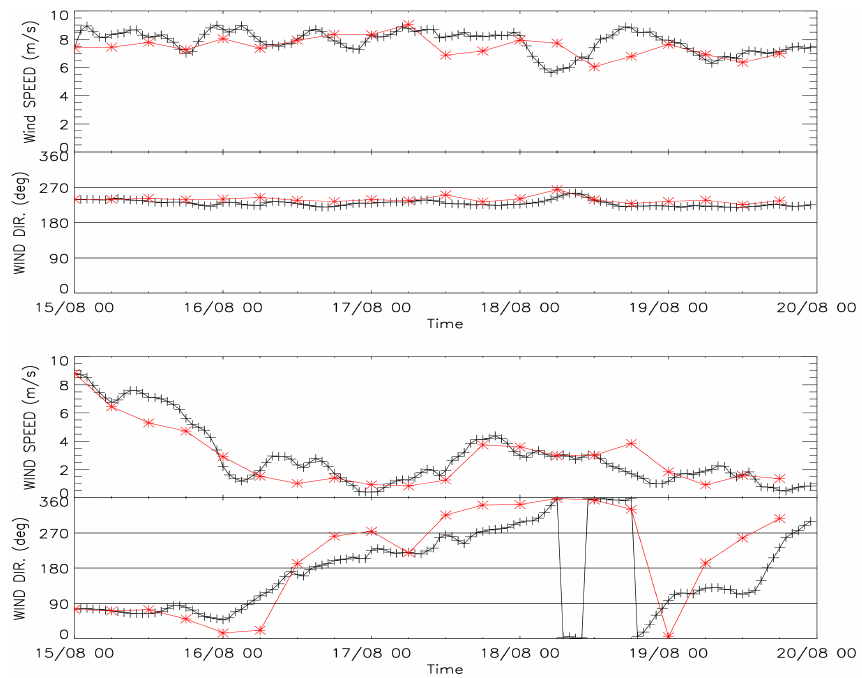
Fig. 9. Time evolution of wind speed and wind direction for the 8km-anthro simulation (black line) and for ECMWF AMMA re-analyses (red line) above Cotonou. Values are averaged over the 0–1km (upper panels) and the 1.5–3km (lower panels) altitude ranges.